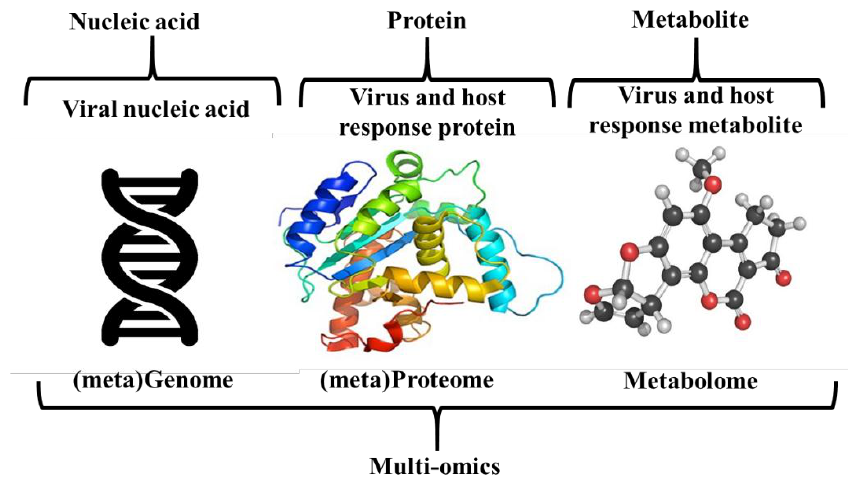
Figure 3. Omics-based virus monitoring approaches.